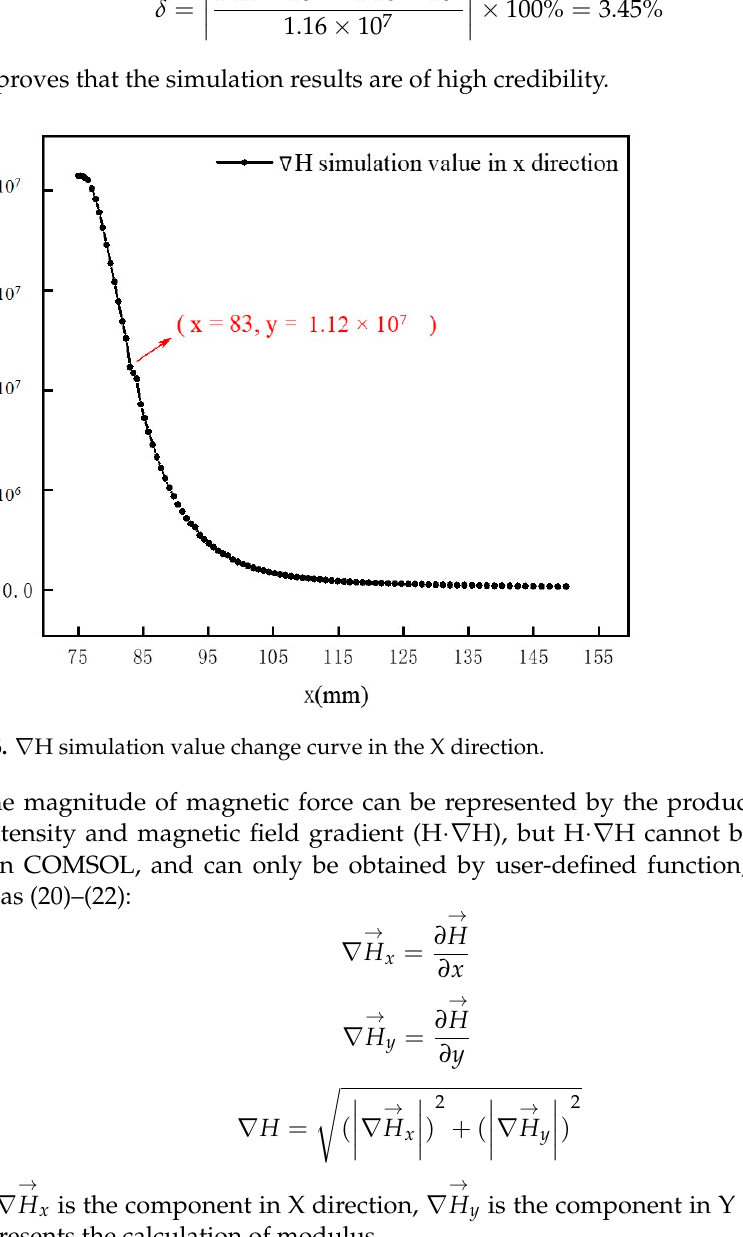
where ∇ 𝐻(cid:4652)(cid:4652)⃗ (cid:3051) is the component in X direction, ∇𝐻(cid:4652)(cid:4652)⃗ (cid:3052) is the component in Y direction, and “ | | ” represents the calculation of modulus.